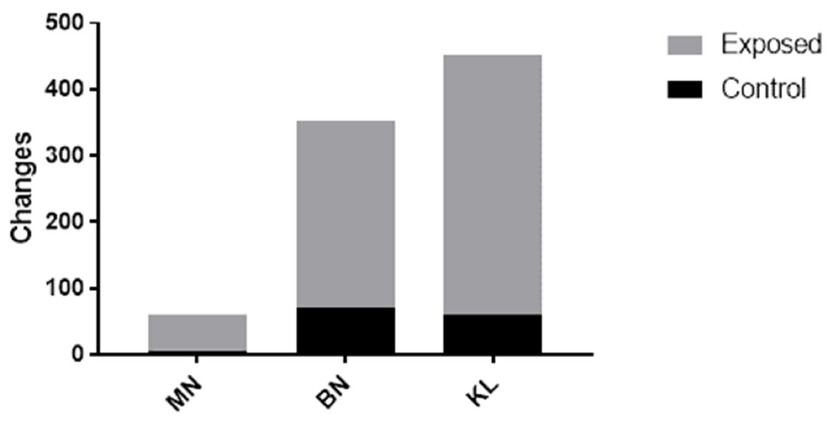
Figure 3. Distribution of nuclear abnormalities of the control (black) and exposed (gray) groups. p < 0.05 according to the sample paired t -test. Table 2. Influence of age, alcohol consumption, and smoking on the genotoxicity biomarkers stud- ied.